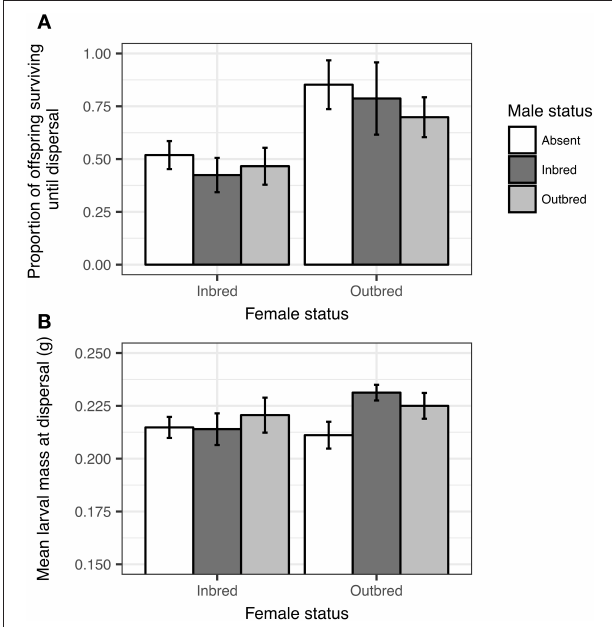
FIGURE 1 | Effects of maternal inbreeding (inbred or outbred) and male status (inbred, outbred, or absent) on the proportion of offspring surviving until dispersal (A) , and on mean larval mass at dispersal (B) . Mean ±